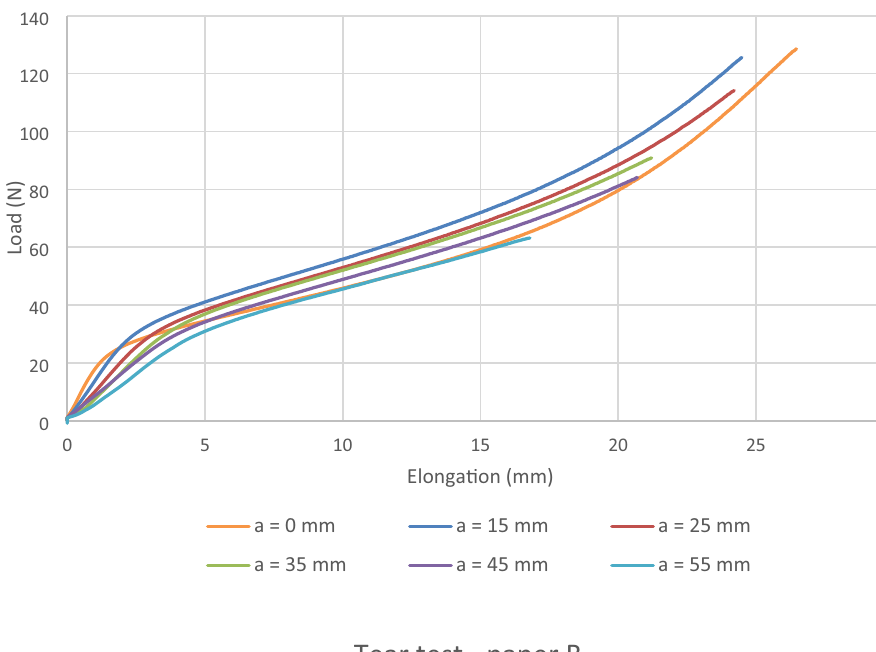
Fig. 11 Tear test curves of paper B per